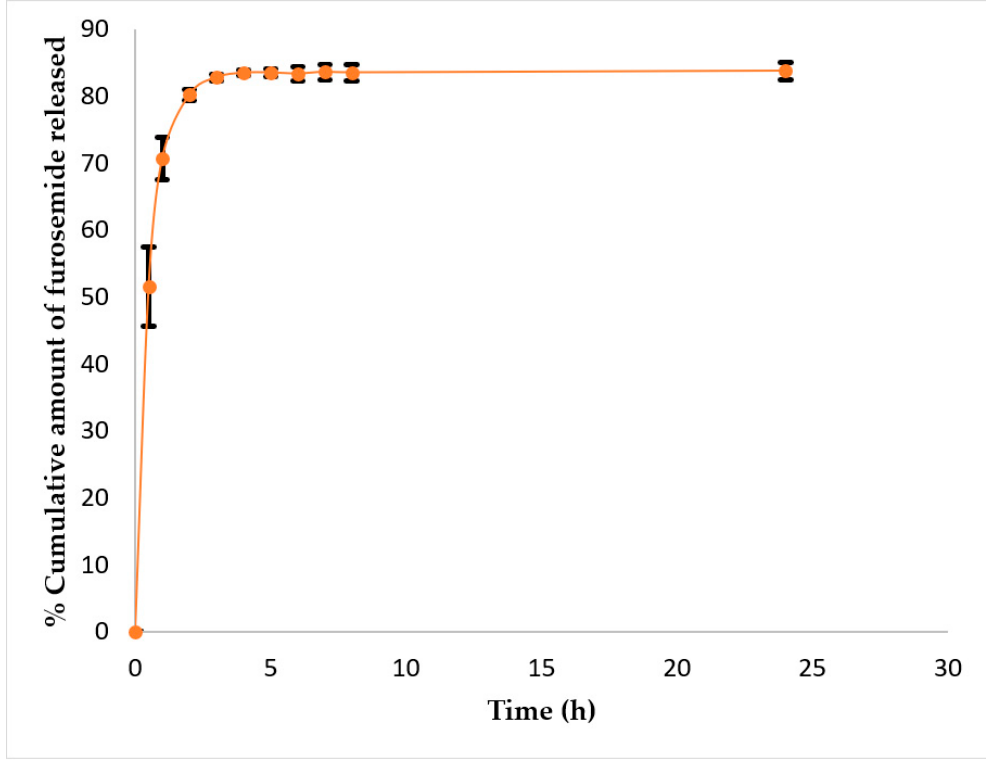
Figure 4. Furosemide release profile from OA-mPEG5000 polymersomes. Data are represented as mean ± SD (n = 3).